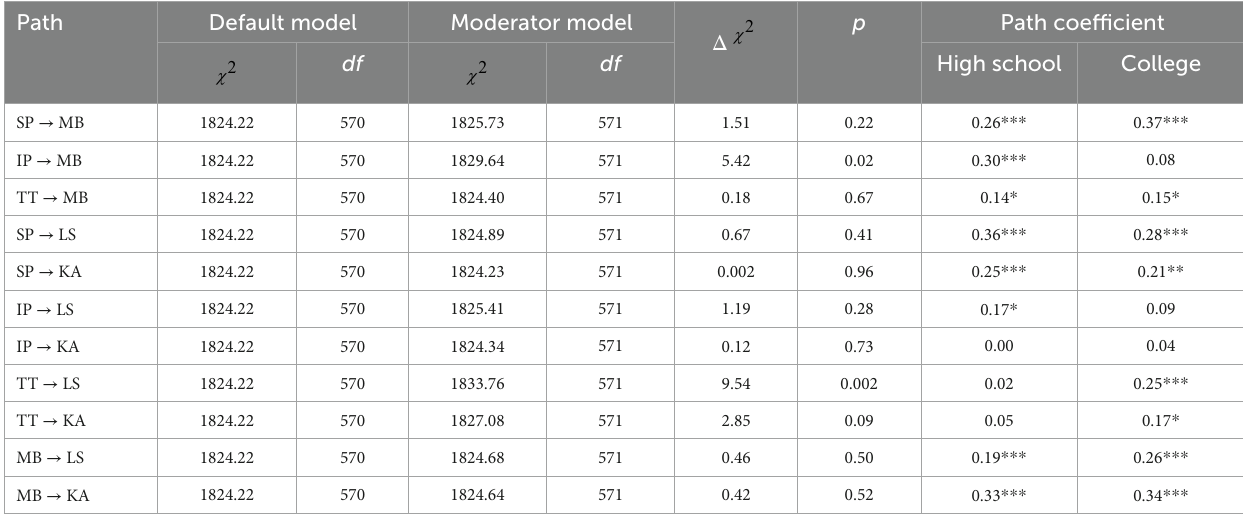
TABLE 3 Cross-group path coefficient invariance test results.